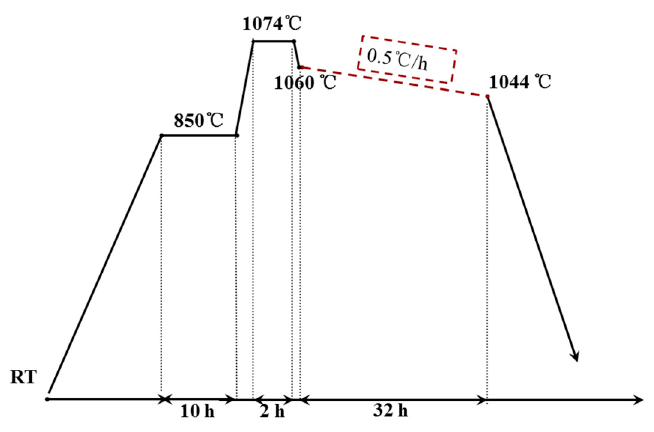
Figure 2. Heat treatment profile used for the drilled single domain SmBCO bulk superconductor.